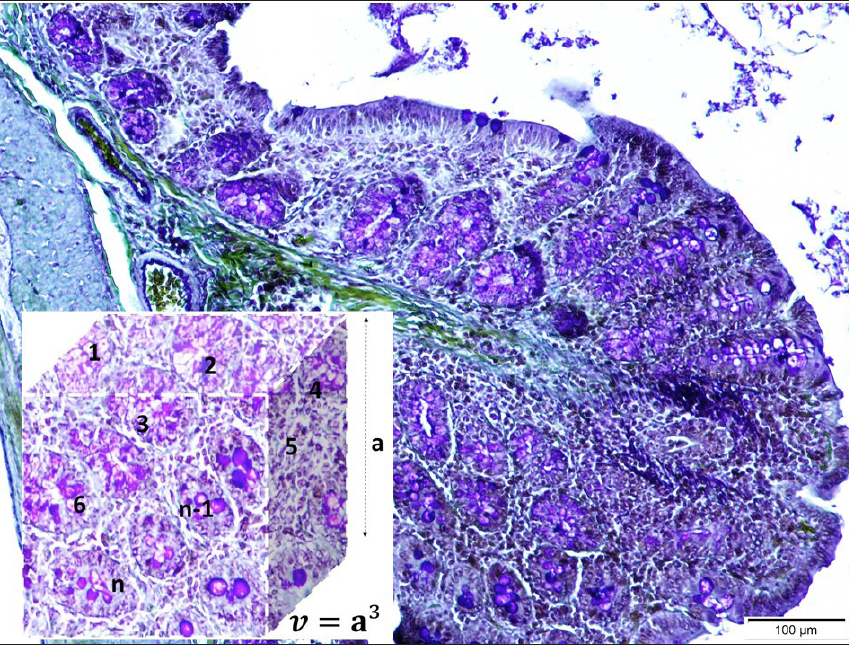
Figure 6. Histological view of the normal intestinal villi (NV) (LM, Aldehyde Fuchsin, x10/A), of a normal animal. To count the epithelial cells on the villi, the number of cells in a cubic millimeter is determined stereologically.